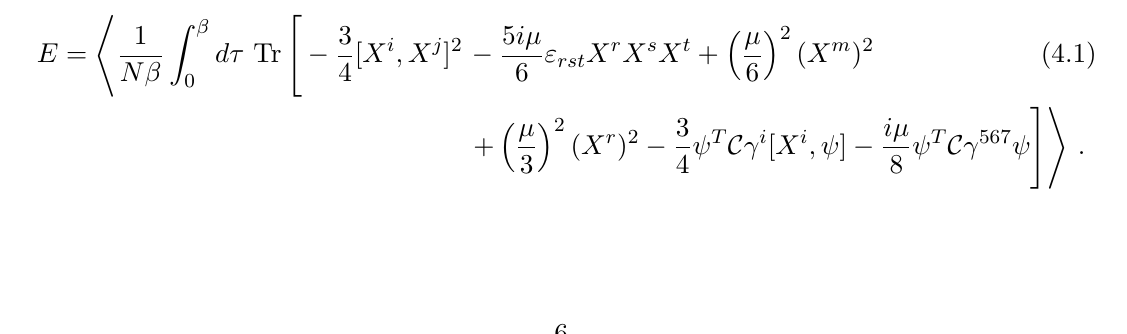
In practice, the parameter values for our simulations were r = (cid:0) 1 r (cid:25) 0 : 148. We chose r = (cid:0) 1 2 f